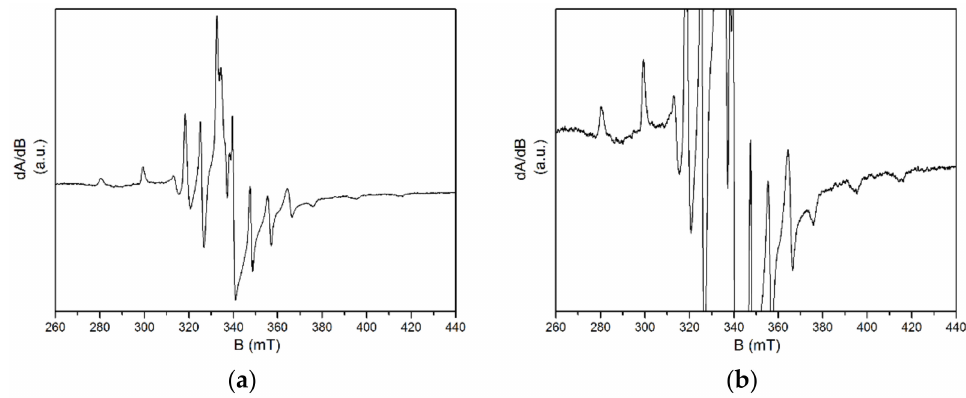
Figure 5. EPR spectrum of the coating VO/S401 cured for 100 days: ( a ) Full spectrum; ( b ) Magnification of weak